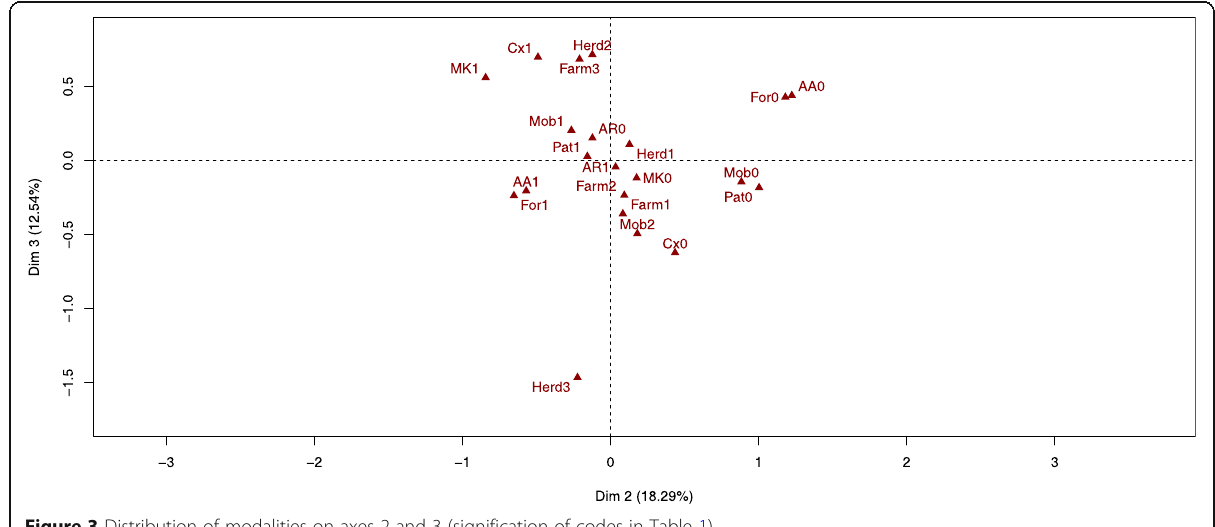
Figure 3 Distribution of modalities on axes 2 and 3 (signification of codes in Table